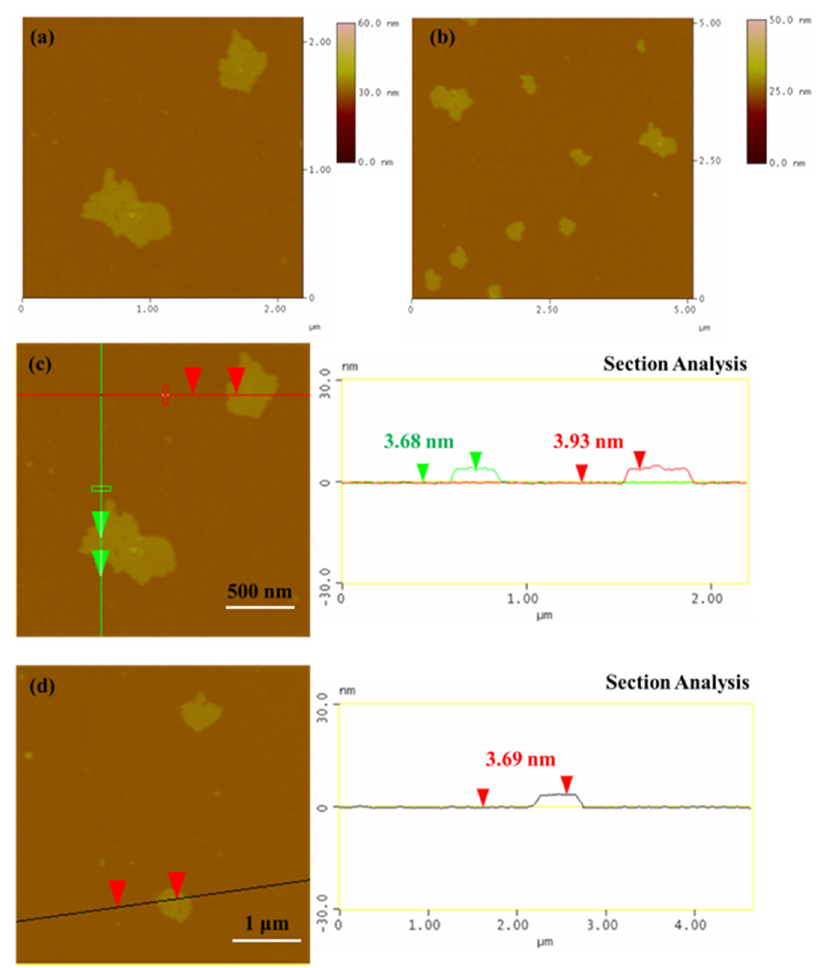
Figure 3. Morphology of the bio-Graphene flakes: ( a , b ) AFM images, and ( c , d ) height profile analysis along the lines marked in the images.